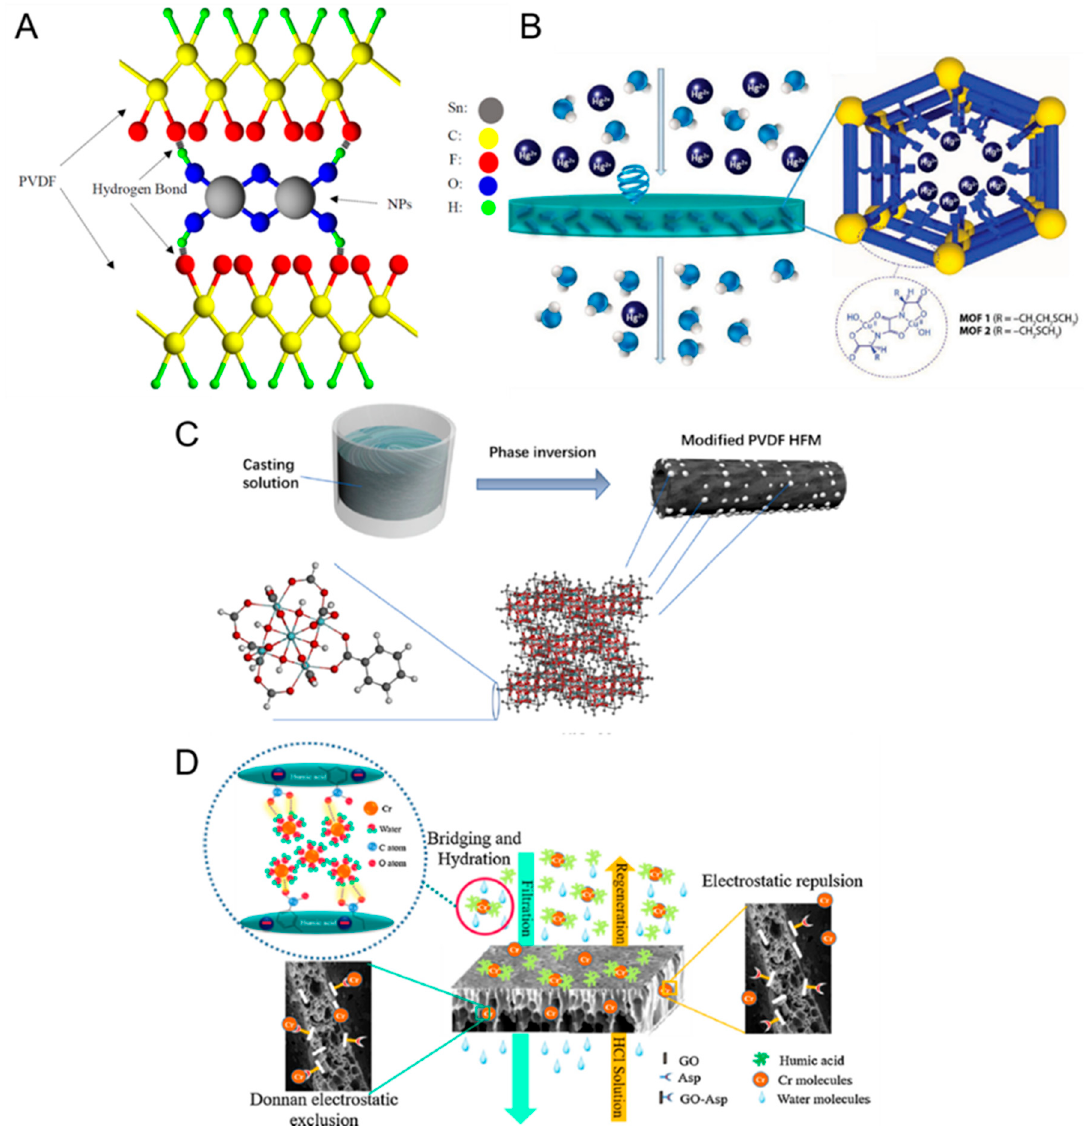
Figure 3. ( A ) Schematic illustration of the possible interaction between PVDF and SnO 2 filler materials [37]. The filler materials are anchored onto the PVDF membrane matrix via hydrogen bonding. ( B ) Schematic illustration of the filtration process in which wastewater containing mercury ions is filtered through the MMM. The adsorption of mercury ions onto the MOFs occurs as a result of the interaction between mercury ions and functional groups in the interior of the MOFs channels [38]. ( C ) The fabrication procedure of a hollow fiber MMM incorporated with UiO-66 filler materials [39]. ( D ) The proposed mechanisms of filtration and regeneration processes of the MMM incorporated with aspartic acid-functionalized graphene oxide for chromium ion and humic acid removal [43]. The bulk membrane matrix is made of polyvinylchloride. The regeneration process is done via filtering the membrane with hydrochloric acid. All figures are reprinted with copyright permissions from the respective references.